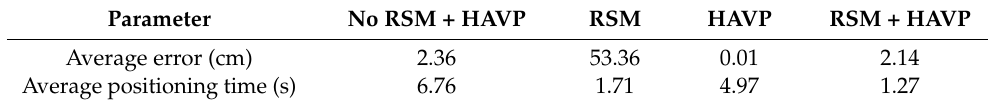
Table 14. Average error and positioning time for methods using and not using RSM and/or HAVP. Parameter